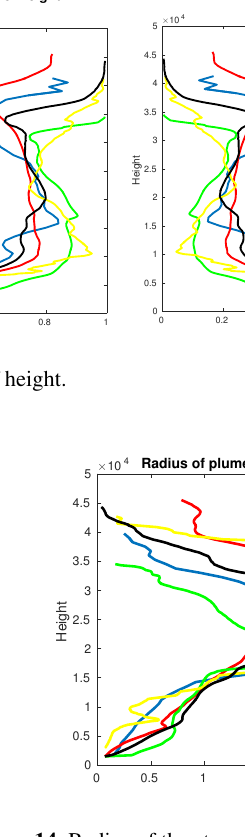
Figure 13. Density of the strong plume without wind after reaching its top height.